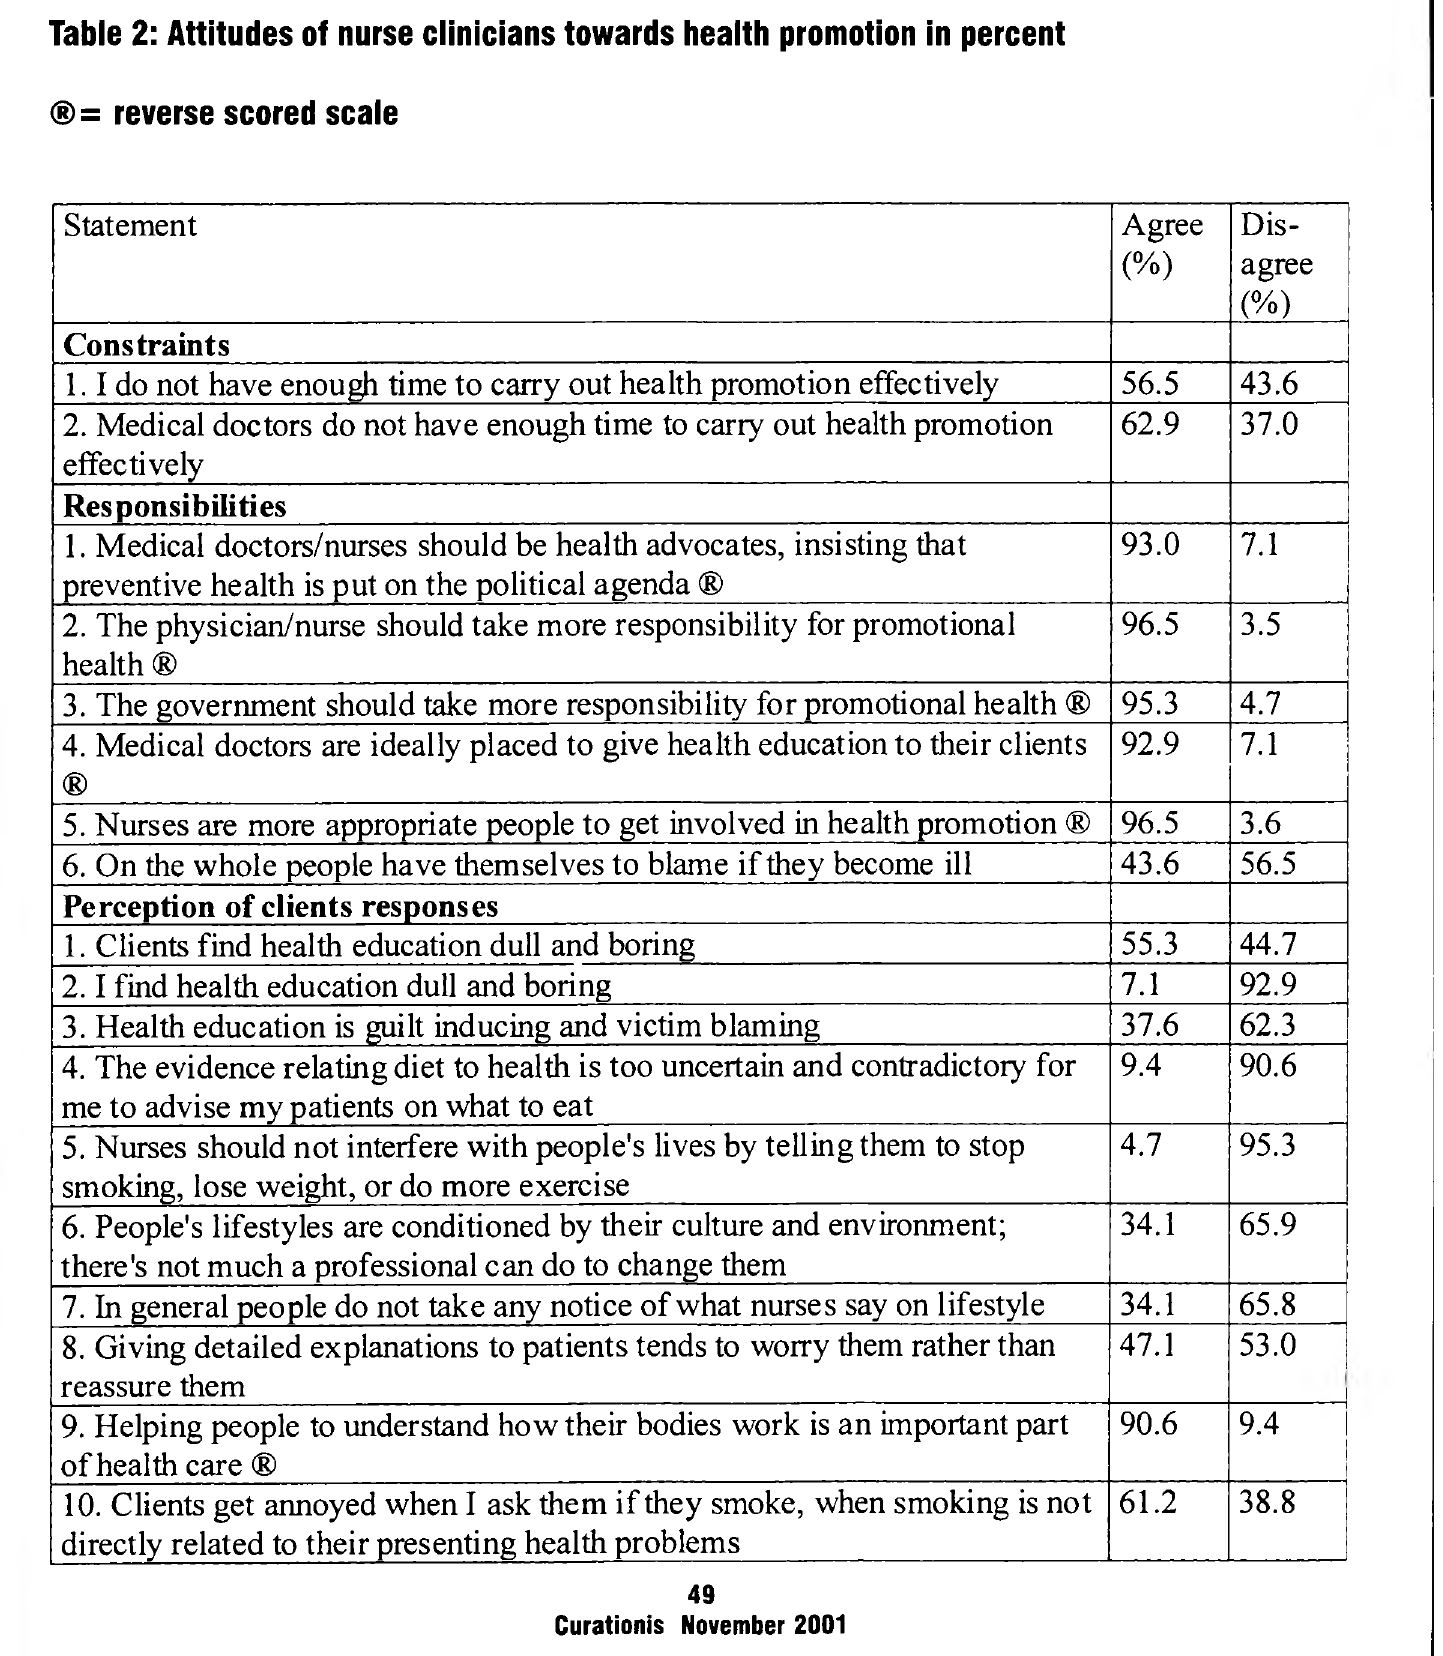
Table 2: Attitudes of nurse clinicians towards health promotion in percent ® = reverse scored